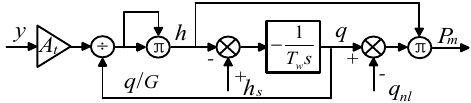
Figure 6. Simplified nonlinear turbine model.